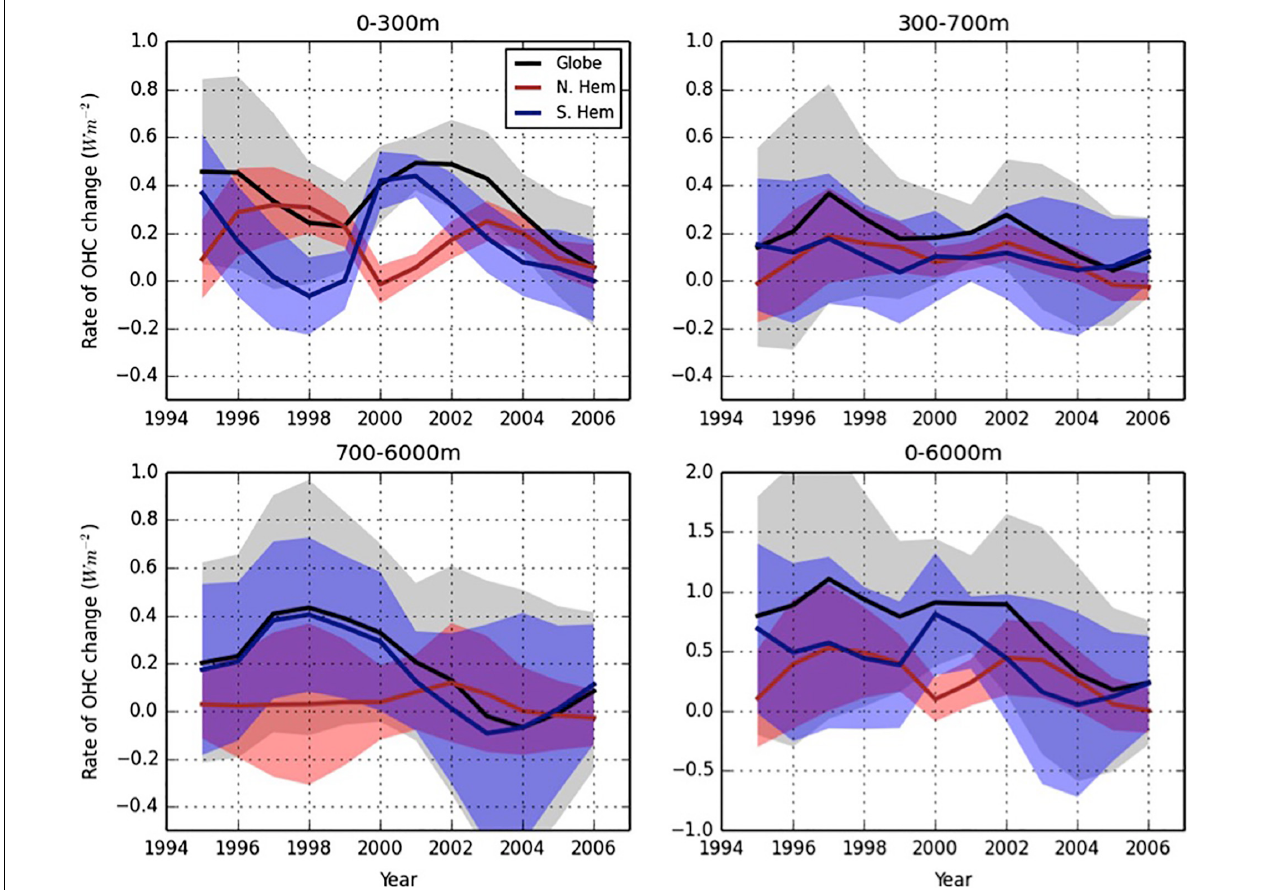
FIGURE 9 | Five-year rolling trends of ocean heat content change over various depth layers for: the Globe ( black ); Northern Hemisphere ( red ); and Southern Hemisphere ( blue ). The solid lines show the ensemble mean with shaded regions indicating ± 1 standard deviation. Changes are expressed as equivalent heating rate, in W m − 2 , relative to Earth’s surface area. Trends plotted relative to the mid-point of each 5-year period. From Palmer et al.